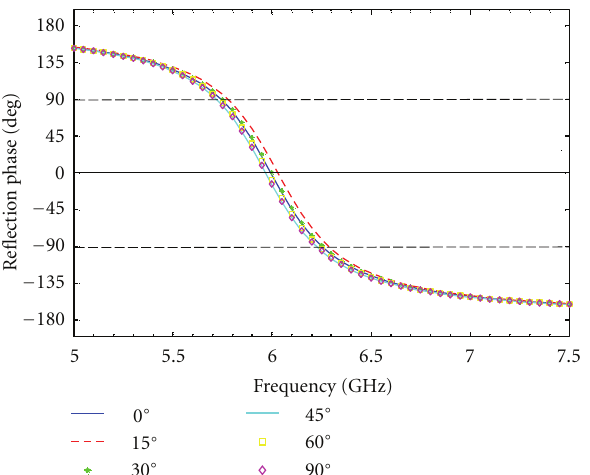
Figure 3: Simulated reflection phase of the AMC surface for TE polarizations for di ff erent incident angles θ inc = 0 ◦ , 15 ◦ , 30 ◦ , 45 ◦ , and 60 ◦